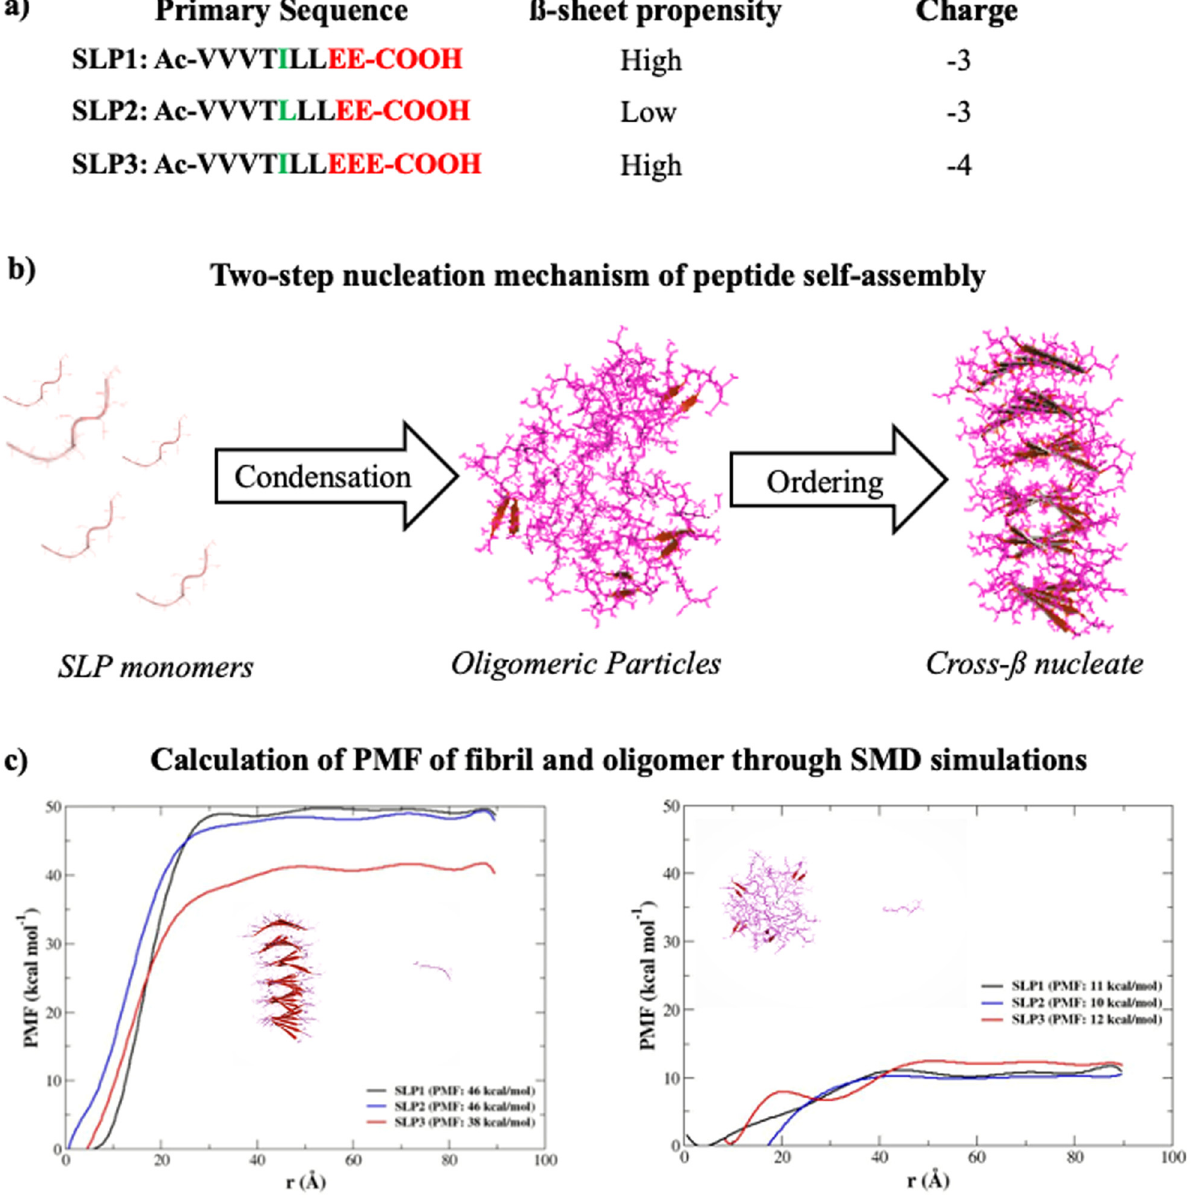
Figure 6: Control over the fi brillization yield by varying the oligomeric nucleation propensities of SLPs. ( a ) Primary sequence of SLPs, isoleucine and leucine, are colored in green, while anionic groups are colored in red. ( b ) Schematic representation of the two - step nucleation of peptide self - assembly, in which peptides fi rst assemble into oligomeric particles through condensation; nucleates are then formed within the oligomeric particles. ( c ) PMF pro fi les of fi bril ( left ) and oligomer ( right ) models along the reaction coordinate derived from SMD simulations provides information on the thermodynamic stability of fi brils and oligomer structures. Increasing the number of charges of the head - groups reduced the structural stability of the fi brils, but, not in the oligomers. A representative snapshot of SMD trajectory is shown in each graph. The fi gure has been adapted from Figures 1a, b and 6a from Lau et al . [ 285 ]